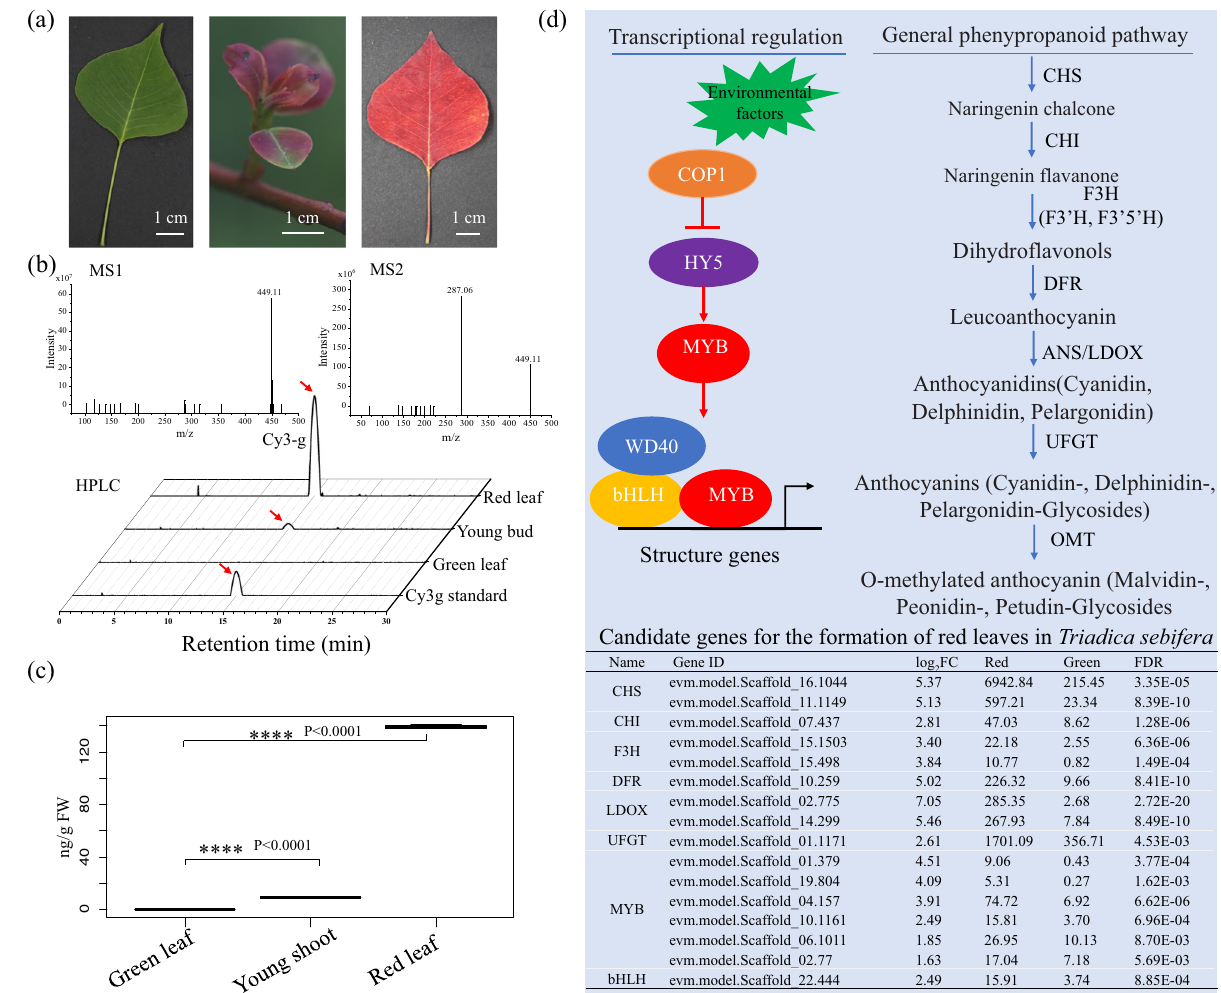
Fig. 5 Analysis of anthocyanin biosynthesis genes in the Chinese tallow tree (CTT) genome. a Three types of leaf samples with different colors were used for anthocyanin measurement and RNA-Seq analysis. b Determination of the major composition of anthocyanin in CTT leaves. Anthocyanins in red leaves were extracted and examined by using a Q exactive plus ultra-high-performance liquid chromatography instrument with a mass spectrometer (UHPLC/MS) (Thermo Fisher, USA) (upper panel), and the content of Cyanidin 3- O -glucoside (Cy3-g) was measured with high-performance liquid chromatography (HPLC) (Waters Alliance-e2695, Waters Corporation, USA) instrument (lower panel). c Contents of Cy3-g in three types of leaf samples. d Anthocyanin biosynthesis genes in the CTT genome. The upper panel indicates the regulation and structure genes for anthocyanin analysis. The bottom panel indicates differentially expressed genes (DEGs) between the red and green leaves for the regulation and structure genes of anthocyanin in the CTT. Columns in this table from left to right are enzyme name, gene ID, Log 2 FC between red to green leaves, reads per kilobase per million mapped reads (RPKM) values for red leaves, RPKM for green leaves, false discovery rate (FDR) for the comparison of red to green RPKM. The full names of these enzymes are CHS chalcone synthase, CHI chalcone isomerase, F3H fl avanone 3-hydroxylase, ANS anthocyanidin synthase, DFR dihydro fl avonol 4- reductase, LDOX leucoanthocyanidin dioxygenase, UFGT uridine diphosphate-glucose: fl avonoid 3- O -glucosyltransferase, OMT O-methyl transferase, and bHLH basic